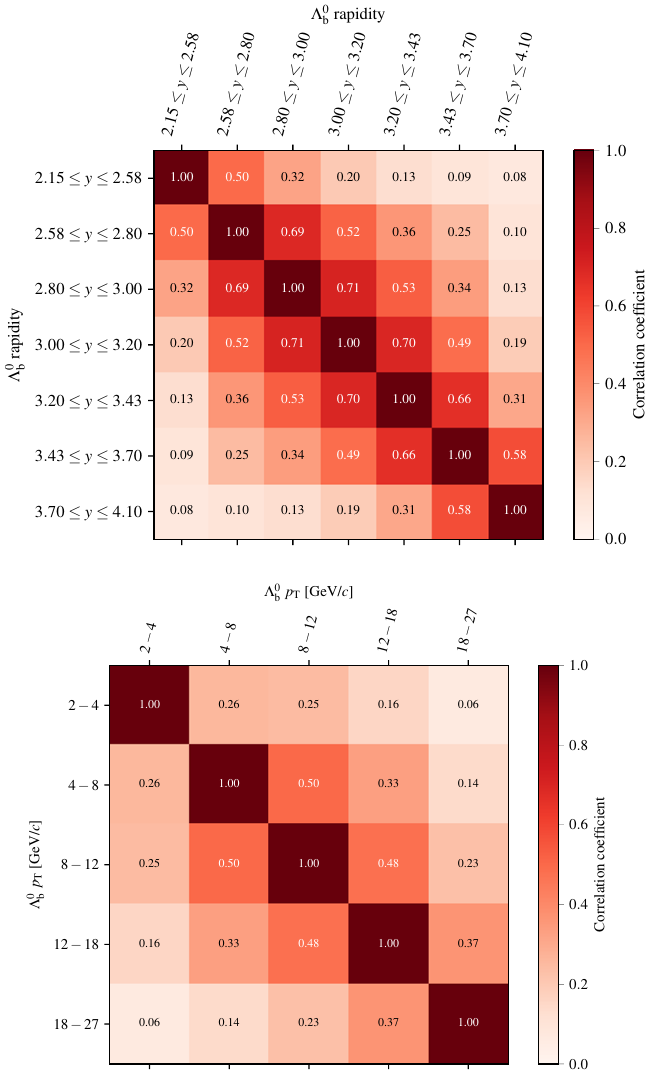
Figure 12 . Correlation coefficients of the total (statistical and systematic) uncertainty on the production asymmetry versus (cid:3) 0 (top) rapidity and (bottom) transverse b